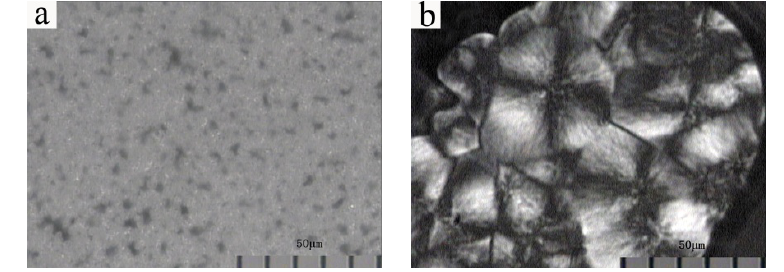
Figure 7. Polarized light optical micrograph of ( a ) NIPS membrane; ( b ) melt spinning